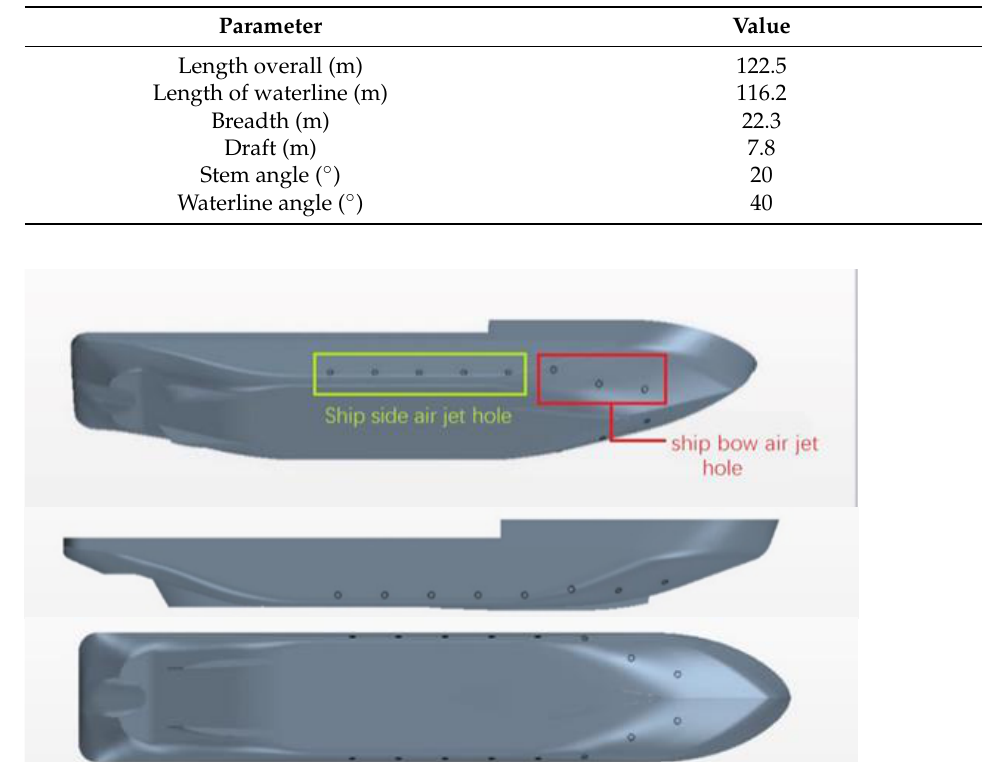
Figure 2. The three-dimensional hull model and the nozzle locations of the air-bubble Figure 2. the three-dimensional hull model and the nozzle locations of the air-bubble system. Table 1. The main particulars of the case study vessel.